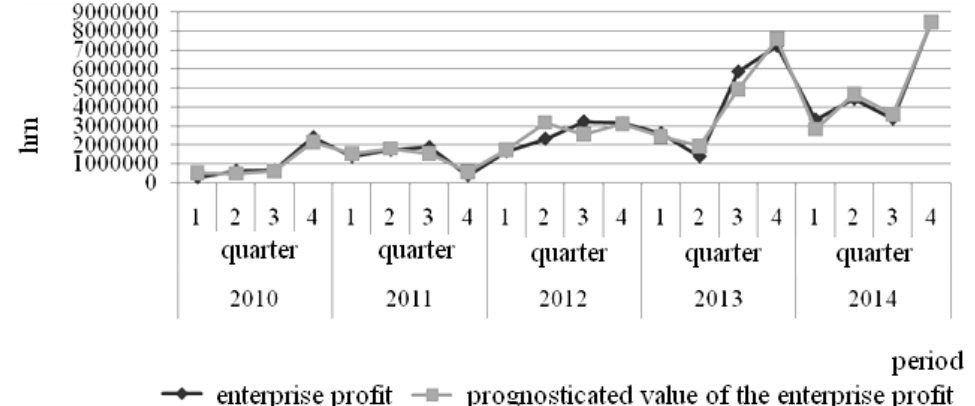
Fig. 2. Dynamics of the real and theoretical levels in LLC “Turbomash” profit due to quarter data during 2010-2014,